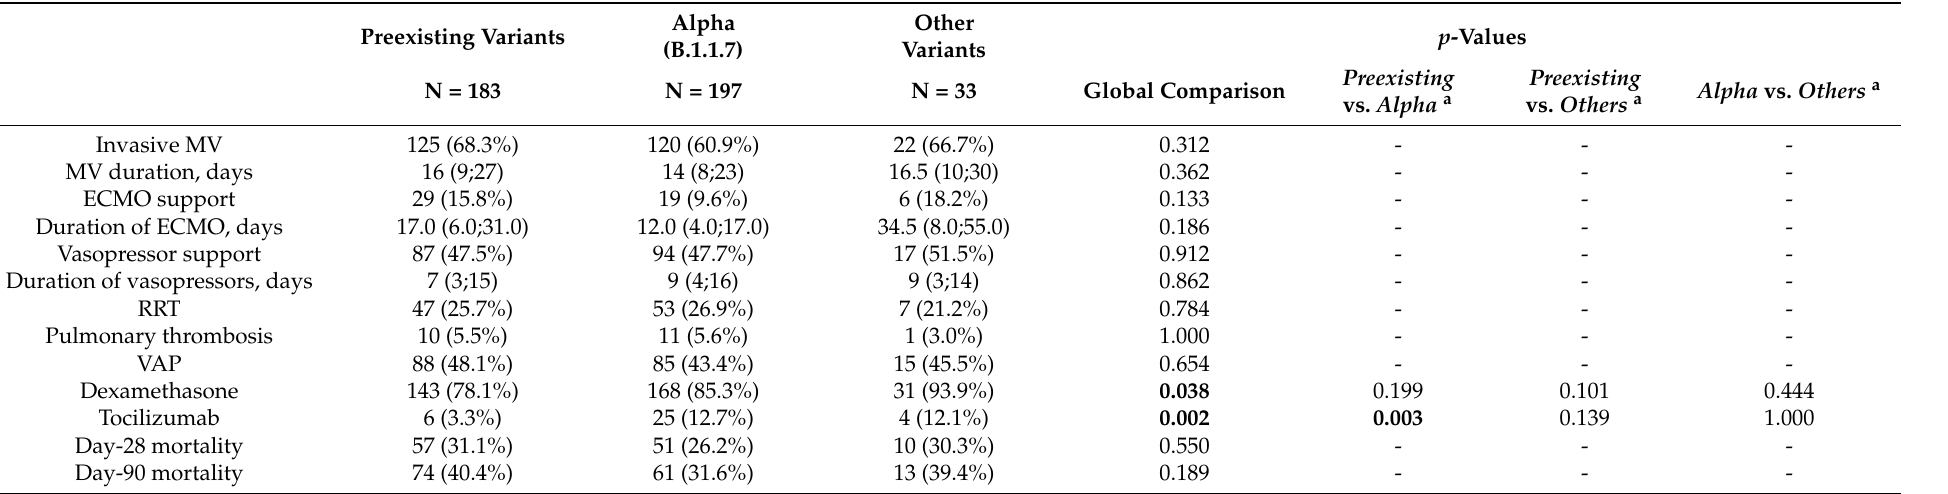
Table 2. Intensive-care management and outcomes of patients with severe SARS-CoV-2 infection (n = 413) during intensive-care-unit stay, according to SARS-CoV- 2